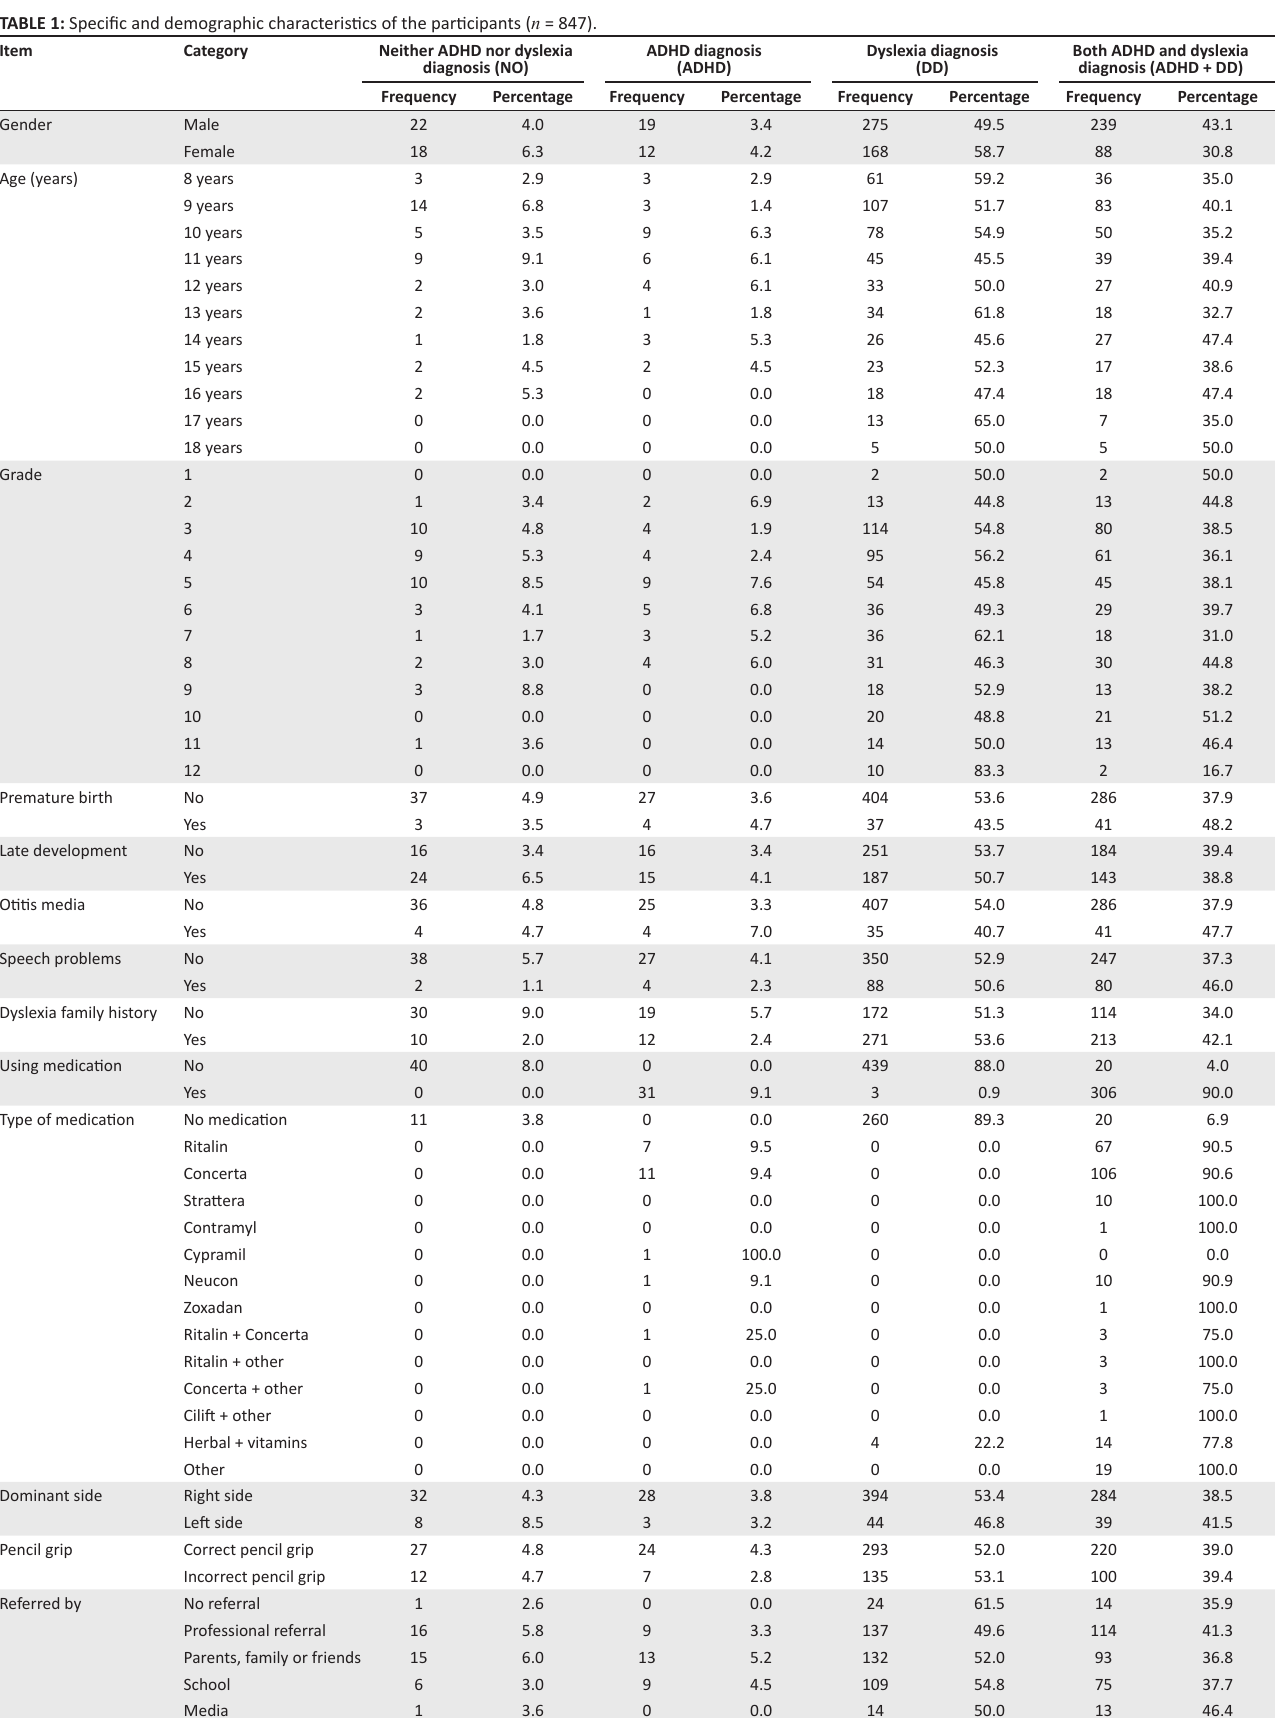
TABLE 1: Specific and demographic characteristics of the participants ( n =